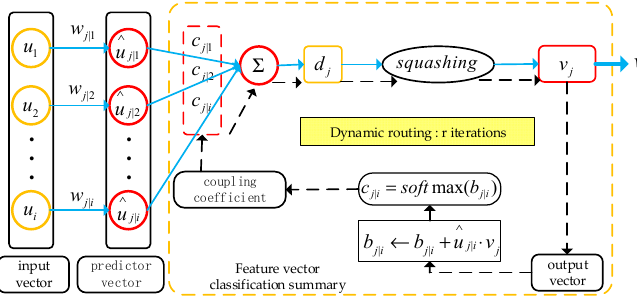
Figure 2. Dynamic routing algorithm.